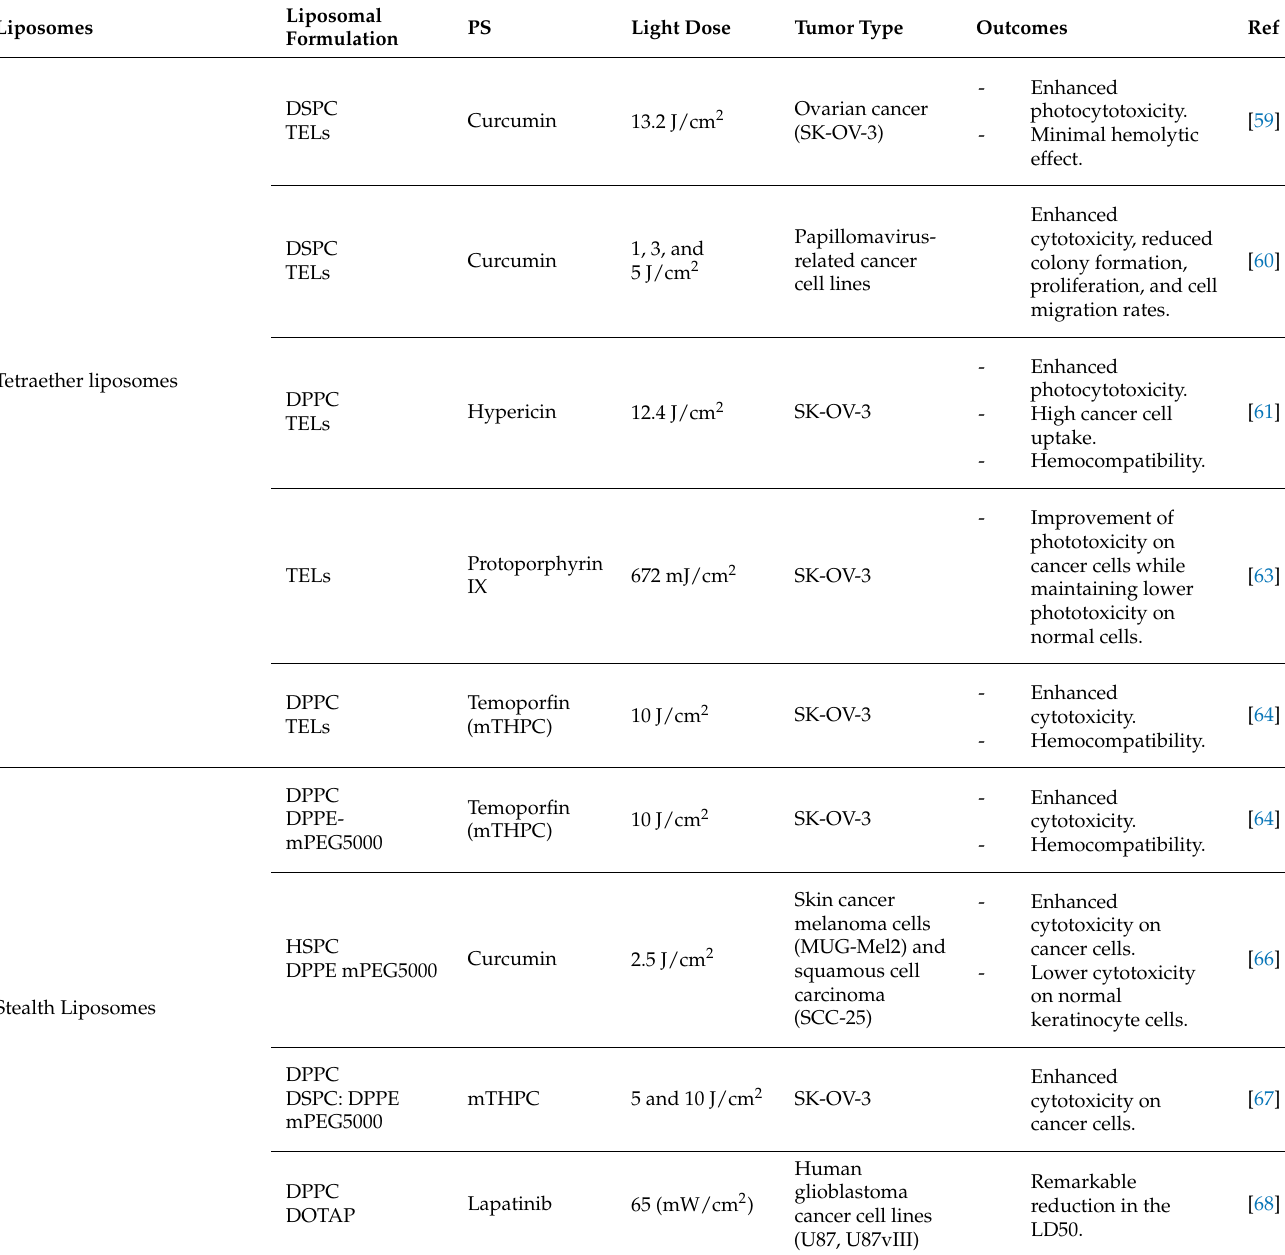
Table 3. Encapsulation of PSs into liposomes in cancer